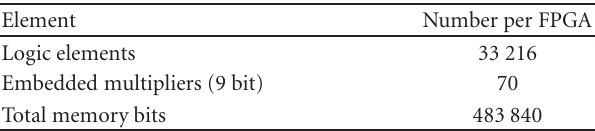
Table 1: FPGA device elements [22].